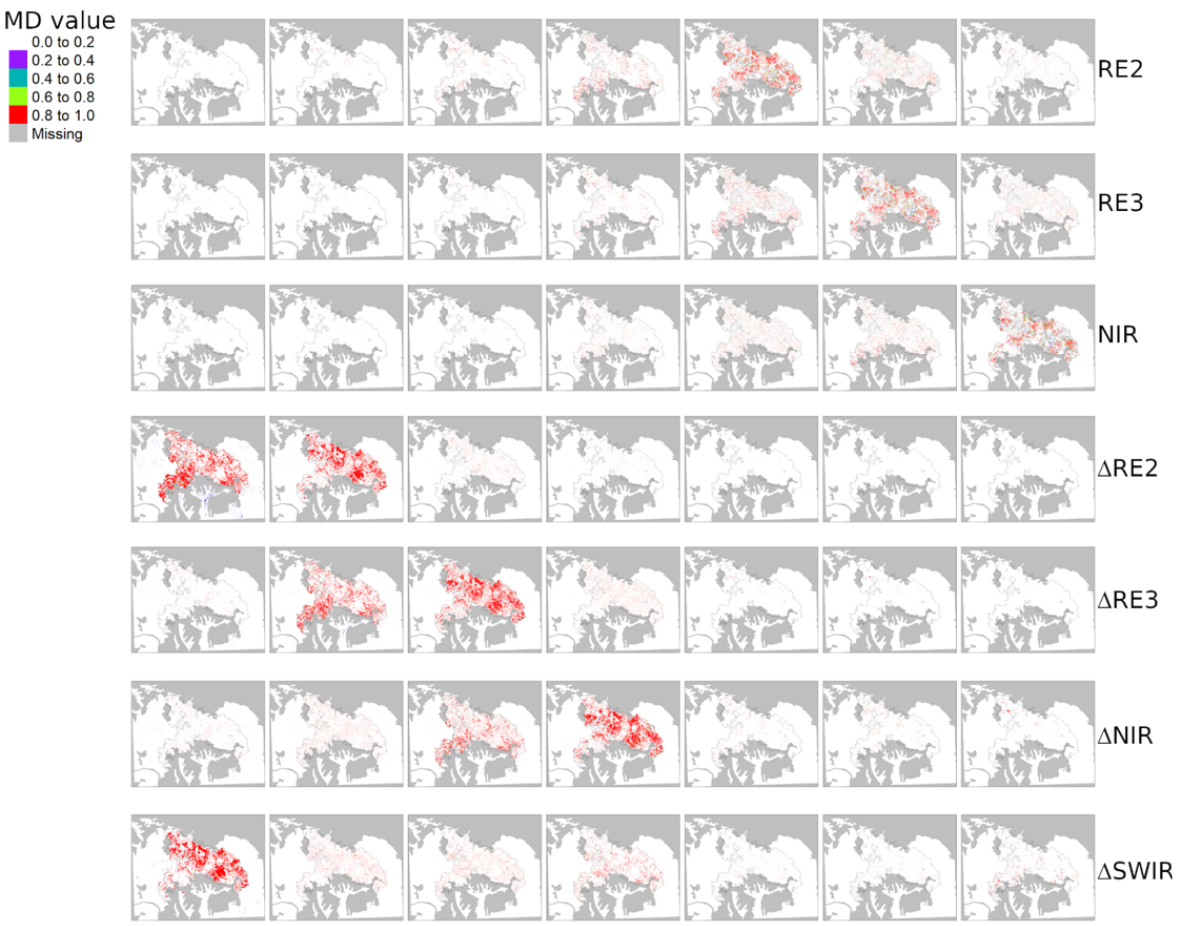
Figure 8. Contribution of each feature MD after the re-ordering step ( g i , i = 1, . . . 7) over the Huelva site, Spain: panels are ordered from left to right to show pixels contributing to the i-th position. Along the columns each pixel value belongs to the n-th features and contributes to the i-th ordered